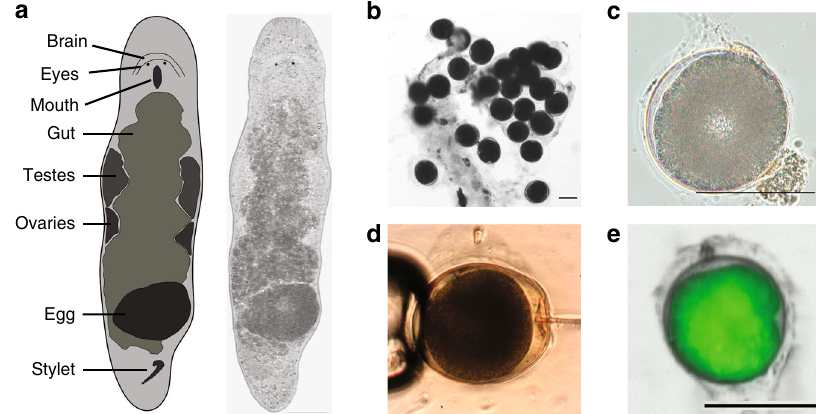
Fig. 1 Macrostomum lignano embryos are amenable to microinjection. a Schematic morphology and a bright- fi eld image of an adult M . lignano animal. b Clump of fertilized eggs. c DIC image of a one-cell stage embryo. d Microinjection into a one-cell stage embryo. e Expression of GFP in the early embryo 3 h after injection with in vitro synthesized GFP mRNA. Scale bars are 100 μ